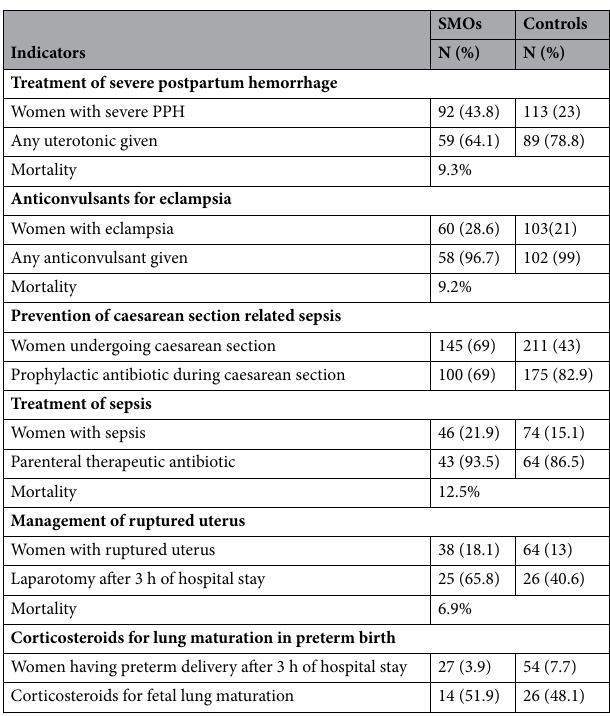
Table 2. Process indicators of specific obstetric conditions among women admitted to Keren Hospital.